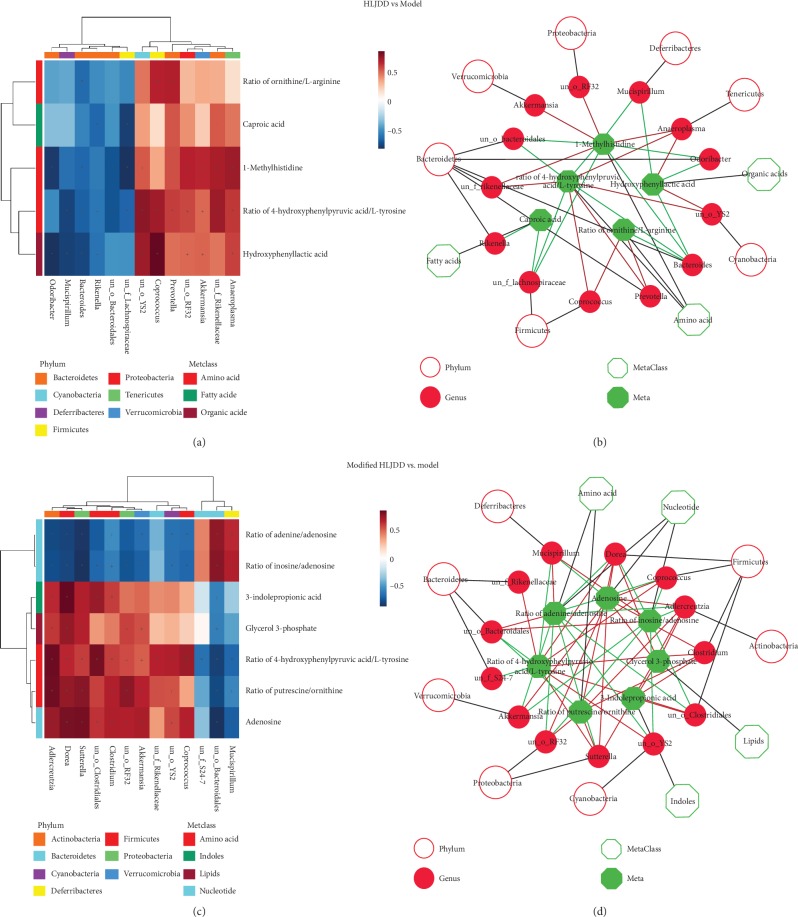
The correlation between significant hippocampal metabolites and gut microbiota in the AD model. (a, b) The correlation between significant hippocampal metabolites and gut microbiota is shown for HLJDD vs. AD model in the form of a heatmap and network diagram. (c, d) The correlation between significant hippocampal metabolites and gut microbiota is shown for modified-HLJDD vs. AD model in the form of a heatmap and network diagram.